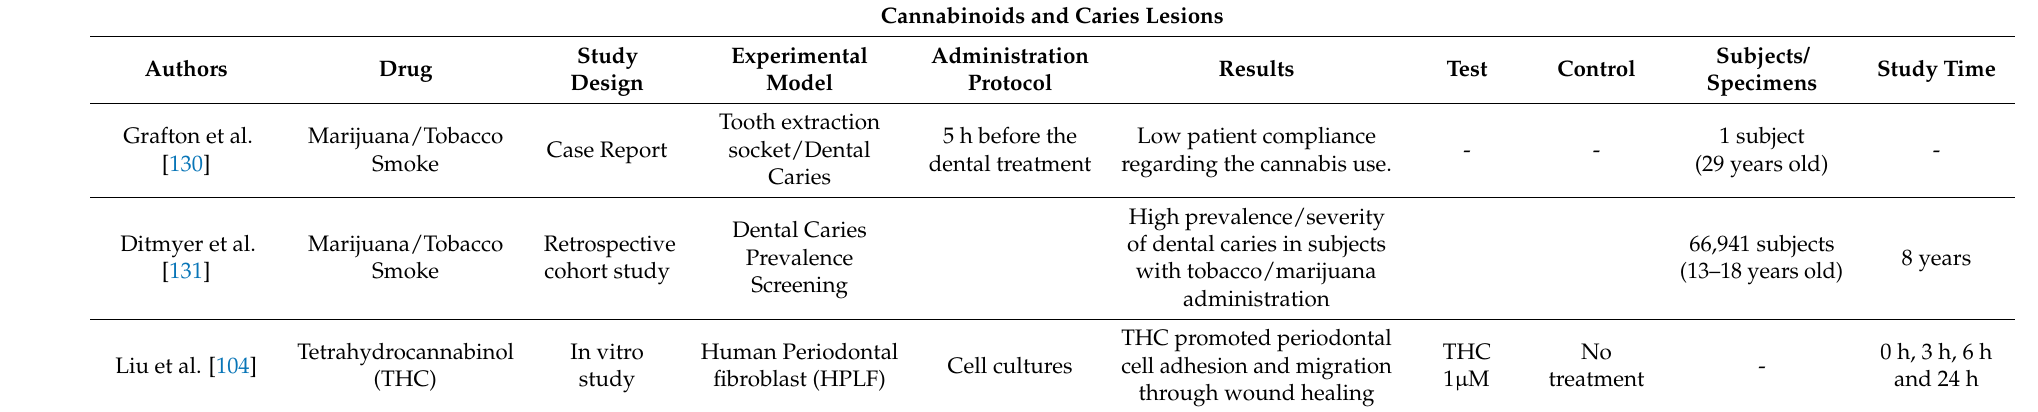
Table 4. Summary of the studies included according to the cannabinoids and caries